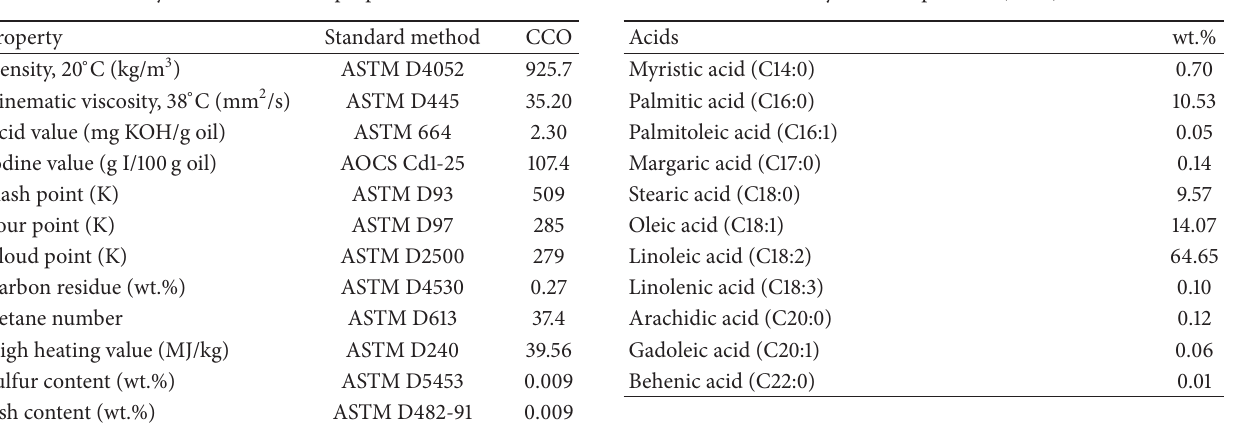
Table 2: Fatty acid composition (wt.%) of